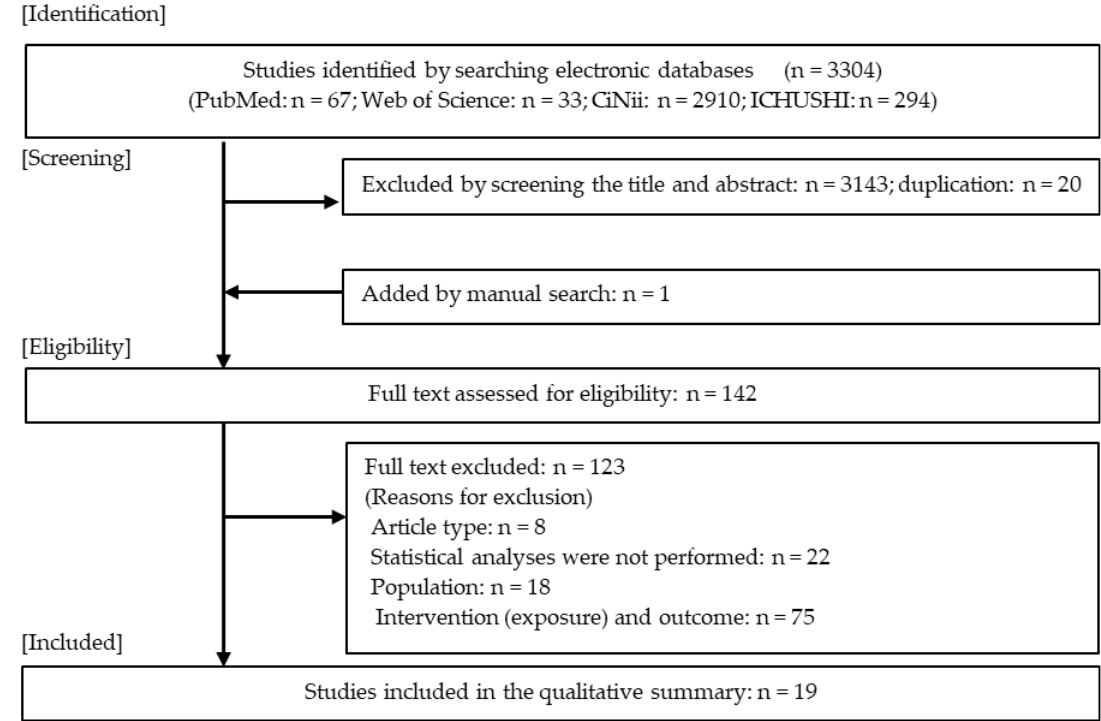
Figure 1. Flowchart of the study selection process.